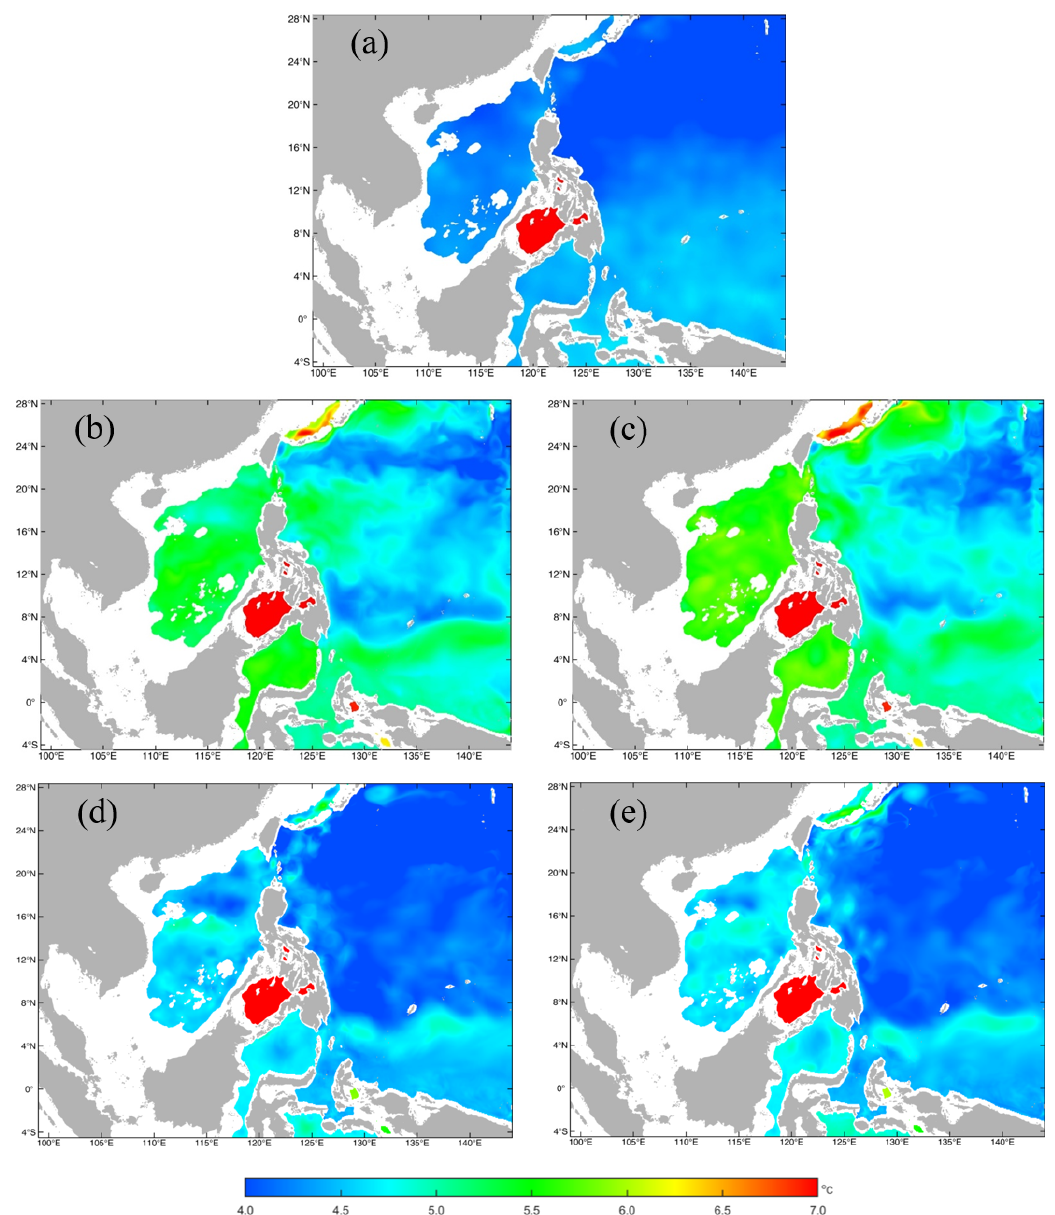
Figure 5. The distributions of the monthly mean temperature in the 1000m layer in January from the (a) GDEMv3 climatology, (b) the 5th and (c) the 11th model year using the scheme combination of the UCI based on SCSOFSv1 for other model settings, and (d) the 5th and (e) the 11th model year using the scheme combination of the AAG based on SCSOFSv2 for other model